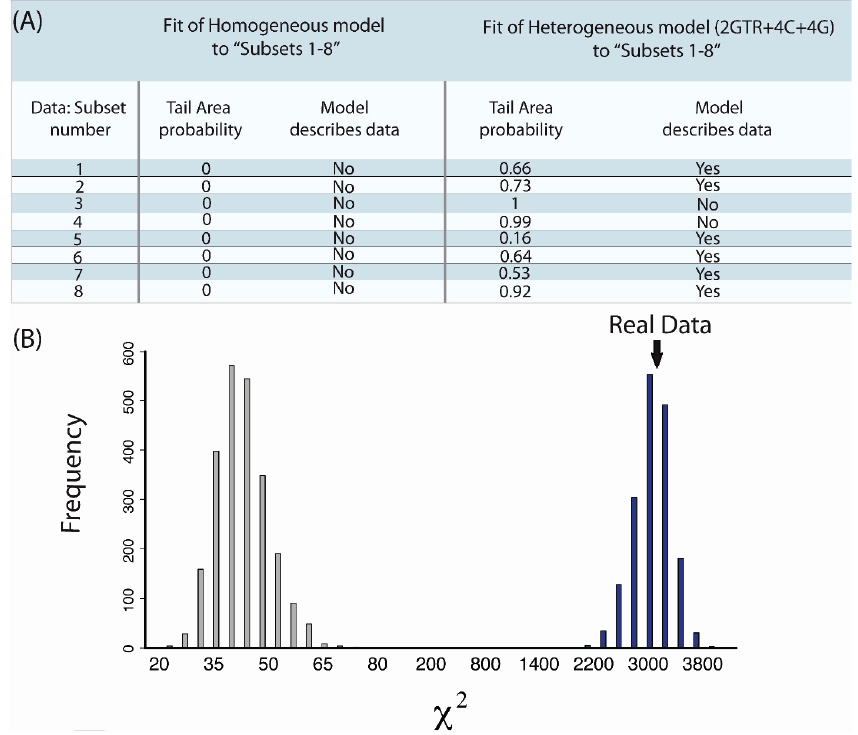
Figure 4. Assessment of fit of Homogeneous and Heterogeneous models for “Subsets 1–8”. ( A ) Posterior predictive simulations for the “Subsets 1–8” are shown. The leftmost